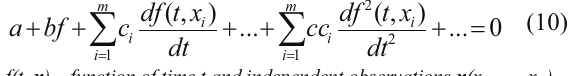
Multi-layer networks form composite polynomial